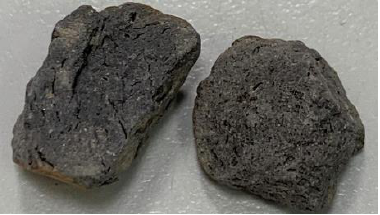
Figure 1. The section of lightweight coarse aggregate. Table 3. Basic properties of the lightweight coarse aggregate used.